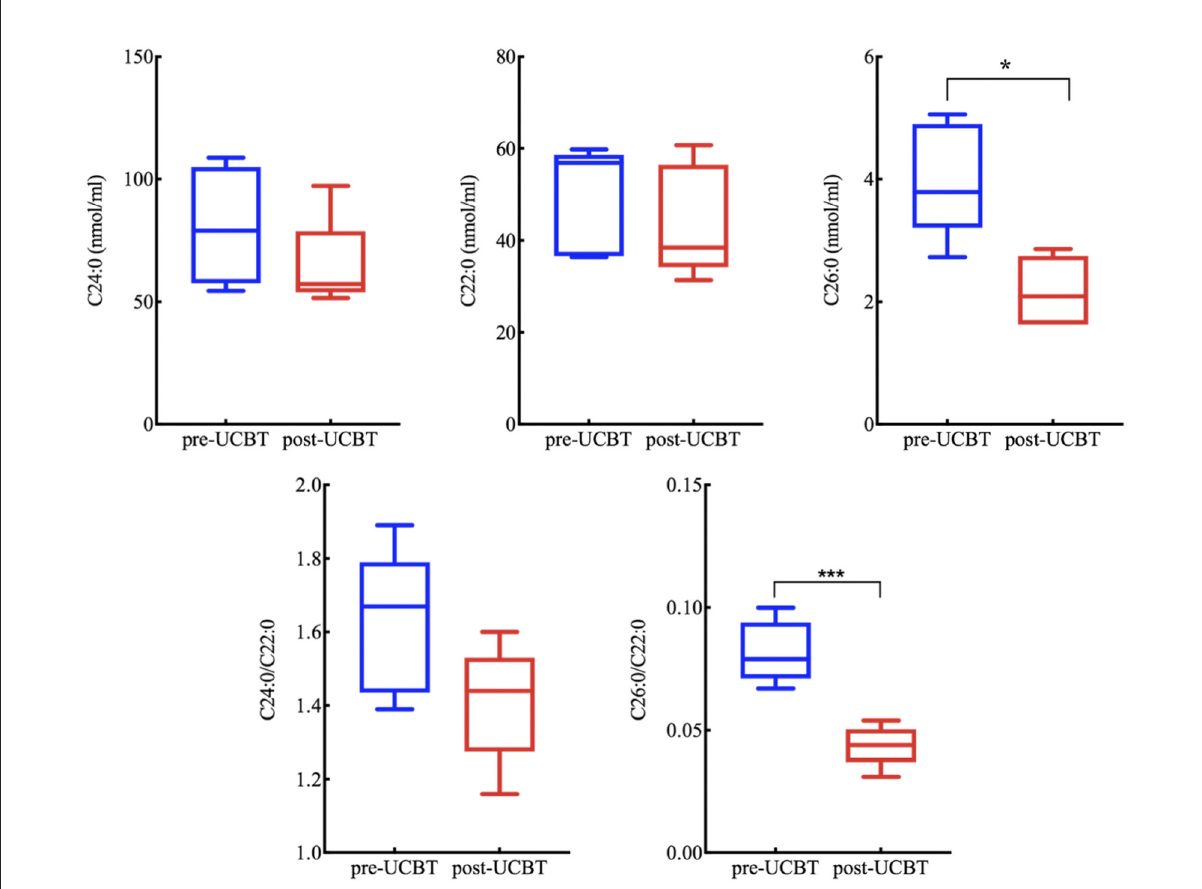
FIGURE3 Serum very-long-chain fatty acid (VLCFA) concentrations for all ALD patients (excluding p2, p4, and p5 without post-UCBT data) were reduced 1 year post-UCBT. (Reference value C22:0 ≤ 96.3 nmol/mL, C24:0 ≤ 91.4 nmol/mL, C26:0 ≤ 1.30 nmol/mL, C24:0/C22:0 ≤ 1.39, C26:0/C22:0 ≤ 0.023). * means P < 0.05. *** means P <